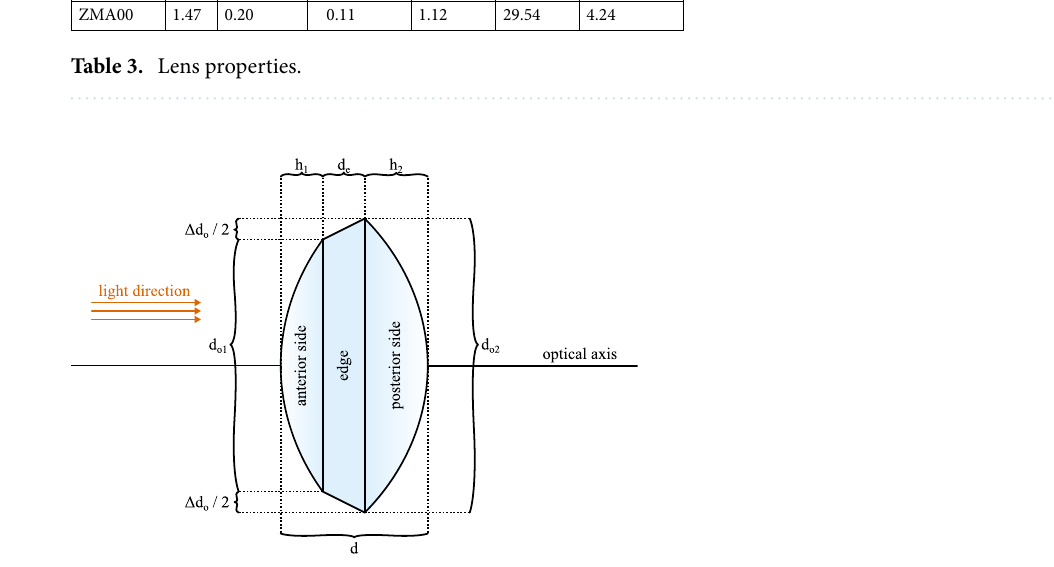
Figure 1. Illustration of lens geometry